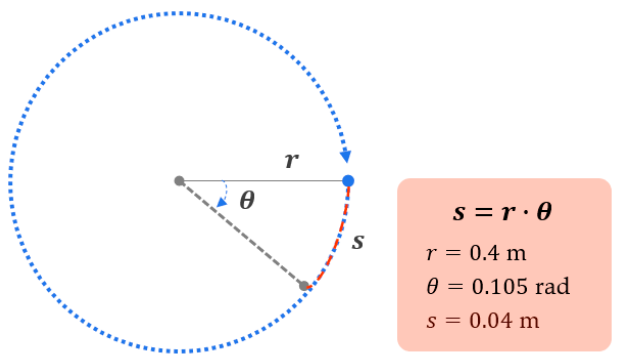
Figure 3. Separation distance according to the angular increment.